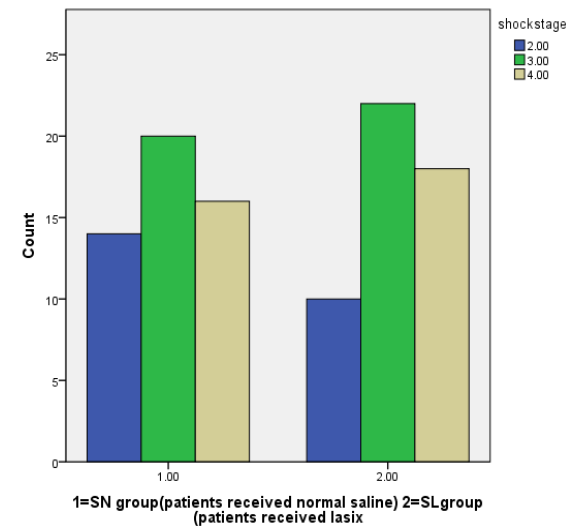
Figure (4): shocked patients received 2 ml normal saline group versus shocked patients received 2 ml Furosemide group in sense of shock stage, there is no significant statistical difference (p=0.216).